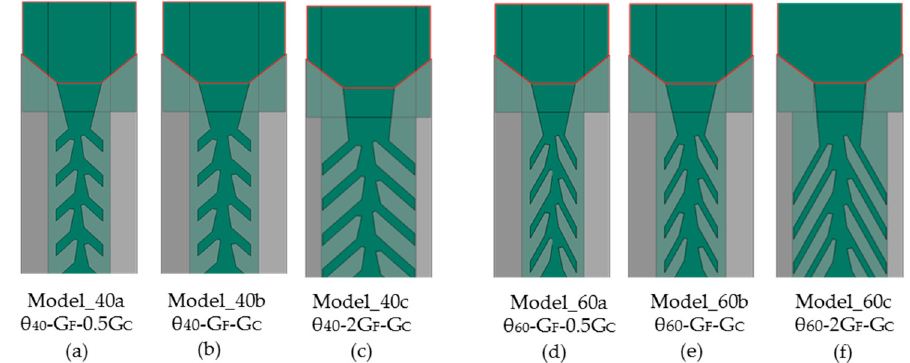
Figure 9. EB-PVD microstructure unit cell models including the TBC inter columnar gaps, molten CMAS domain and an Eulerian domain, generated using the Python script: ( a ) 40° inclined feather arm model with short arm and narrow columnar gap; ( b ) with short arm and wide columnar gap; ( c ) with long arm and wide columnar gap; ( d ) 60° inclined feather arm model with short arm and narrow columnar gap; ( e ) with short arm and wide columnar gap; and ( f ) with long arm and wide columnar gap.